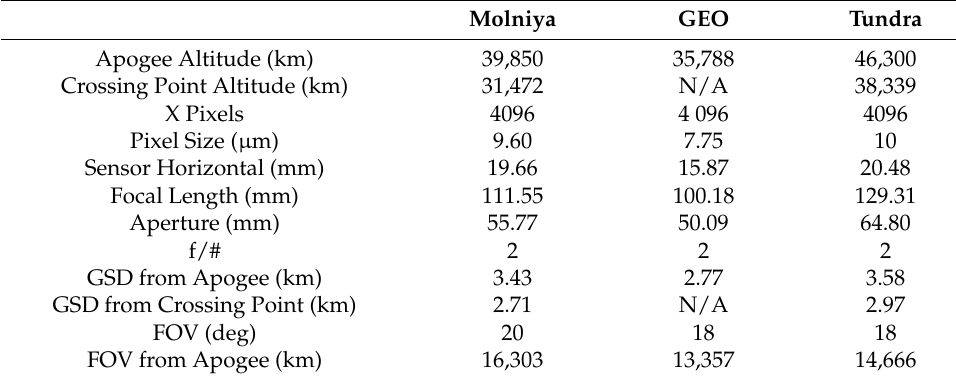
Table 1. Deduced camera parameters and resultant Ground Separation Distance/Field of View (GSD/FOV) at the Earth’s surface.